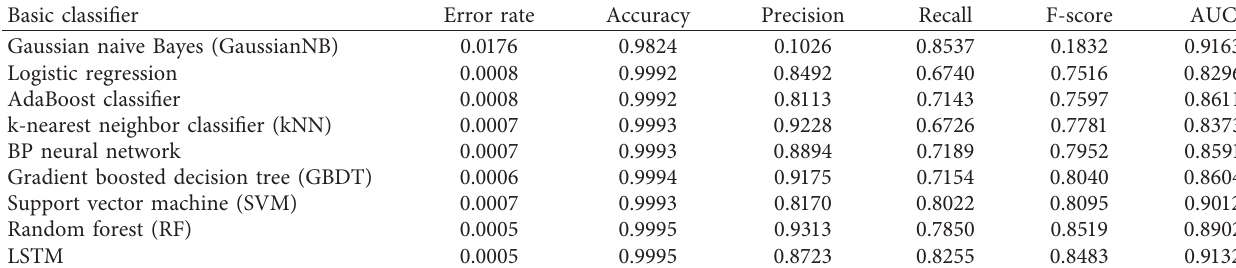
Table 5: Comparison of detection results of basic classifier.